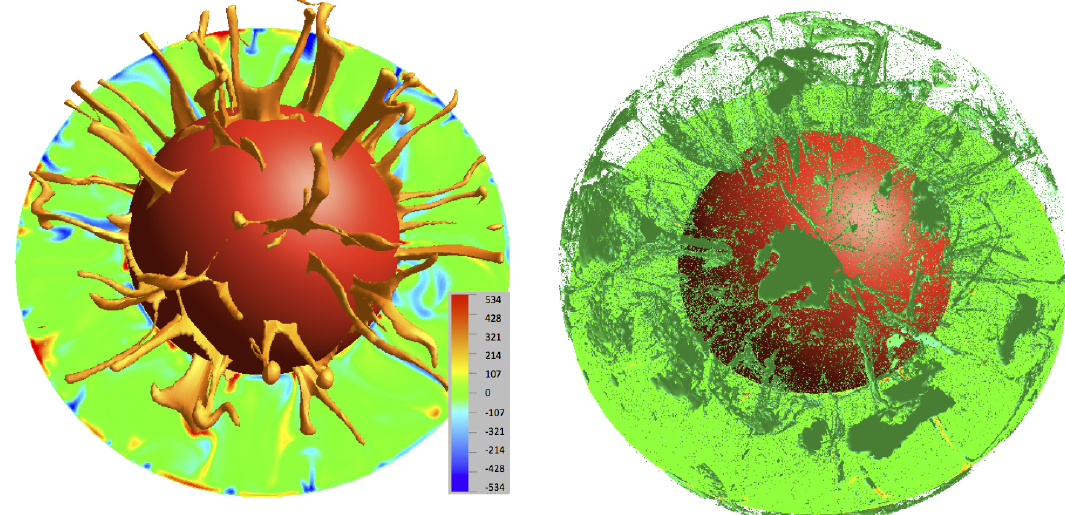
Figure 3. Snapshots of temperature anomaly (left) and matching bulk composition field (right) in the mantle. The red sphere in the middle of the figures is the core–mantle boundary. For the temperature image the isosurface shows where temperature is 200K higher than the horizontal average value (the top 600km is omitted); the cross section shows the temperature deviations from the horizontal average value. The composition shows an isosurface of slightly higher than average basaltic